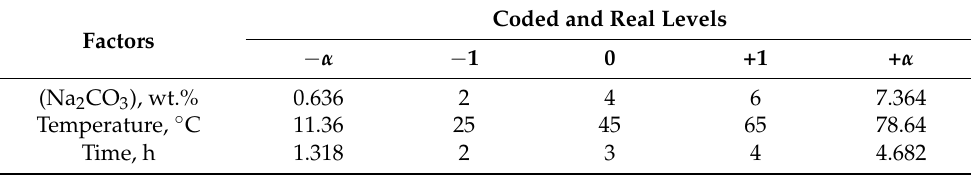
Table 3. Coded and real levels of the factors using central composite design for CEC applying RSM.